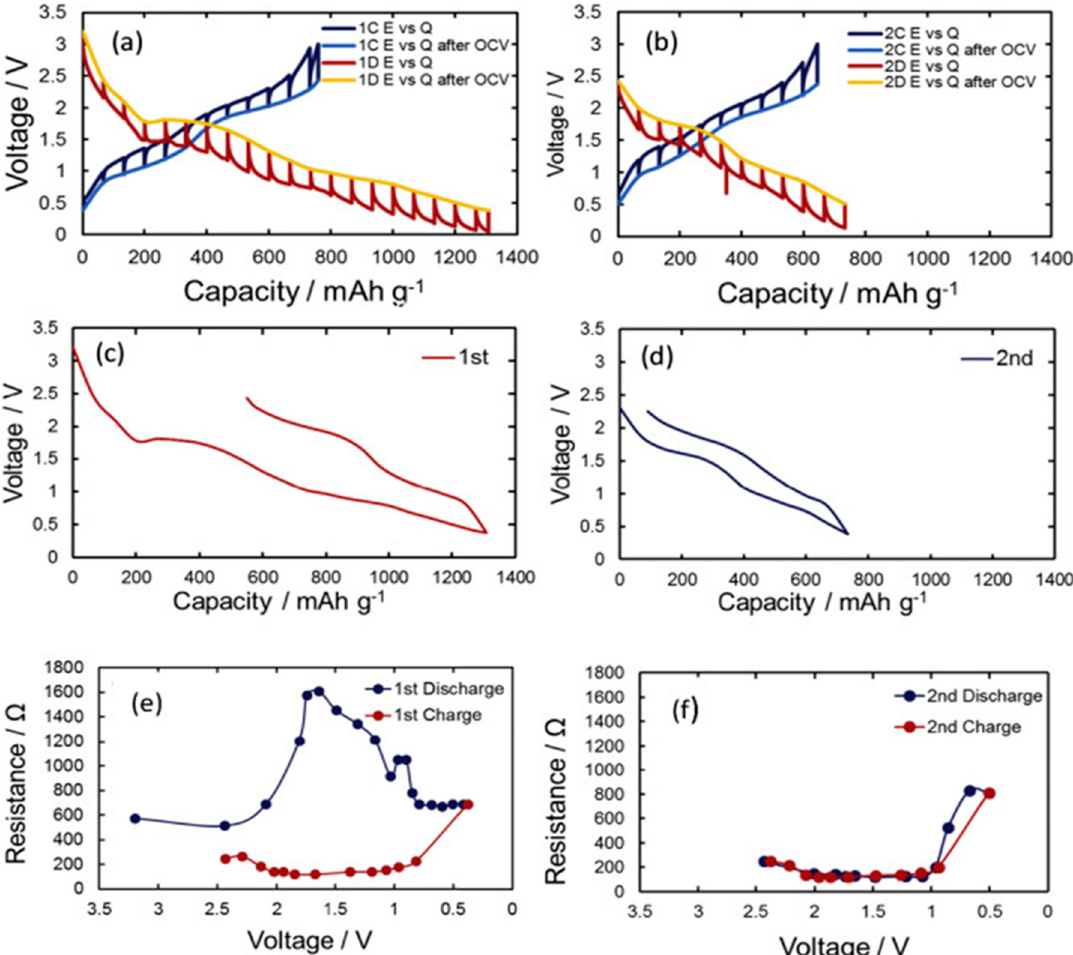
Figure 15. Open Circuit Voltage (OCV) and Closed Circuit Voltage (CCV) curves for the Li/L-BIOX(Biogenous Iron Oxide) cell in both the discharge and charge directions of the ( a ) first and ( b ) second cycles. 80 wt% L-BIOX, 10 wt% CNTs, 10 wt% Styrene-Butadiene Rubber/Carboxymethylcellulose (SBR/CMC). Hysteresis of the OCV curves for the first and second discharge-charge is shown in ( c ) and ( d ), respectively. Potential (OCV) dependence of cell resistance for the ( e ) first and ( f ) second cycles. The intercepts of the semicircle on the real axis at the low-frequency side in is attributed to the total resistance of the cells.